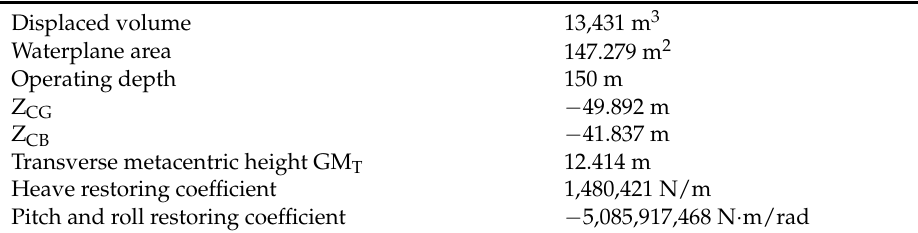
Table 4. Key parameters of FOWT-SFFC in static equilibrium position.